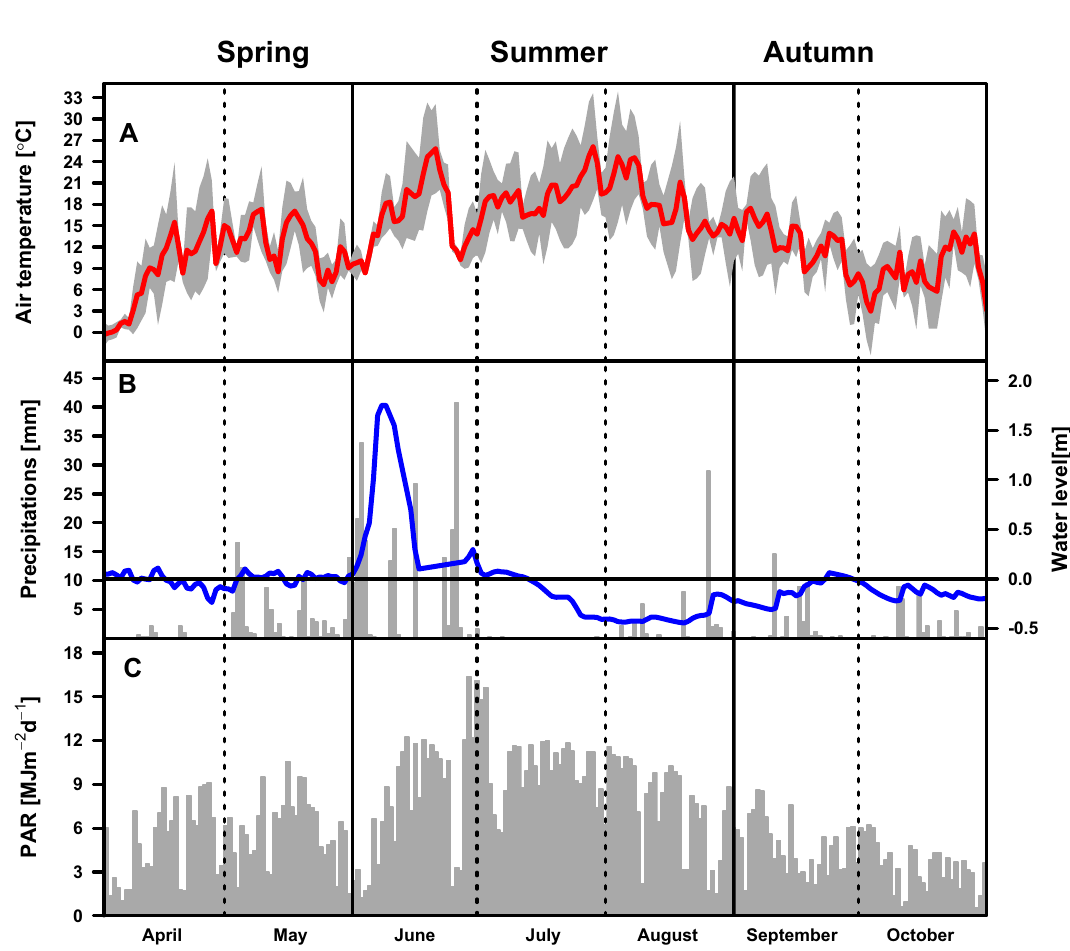
Figure 2. Seasonal courses of ( A ) daily mean air temperature (red line) and its daily fluctuations (grey field), ( B ) daily precipitation (grey vertical bars) and positions of water table (blue line) with ( C ) standard light conditions characterized as daily sums of incident photosynthetically active radiation (PAR) at the sedge-grass